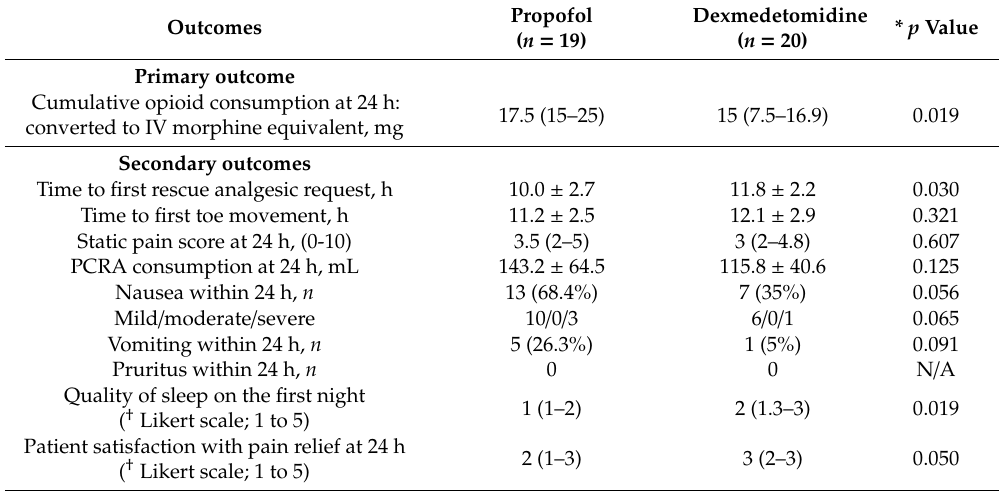
Table 3. Clinical outcome di ff erences between the propofol group and the dexmedetomidine group. Outcomes